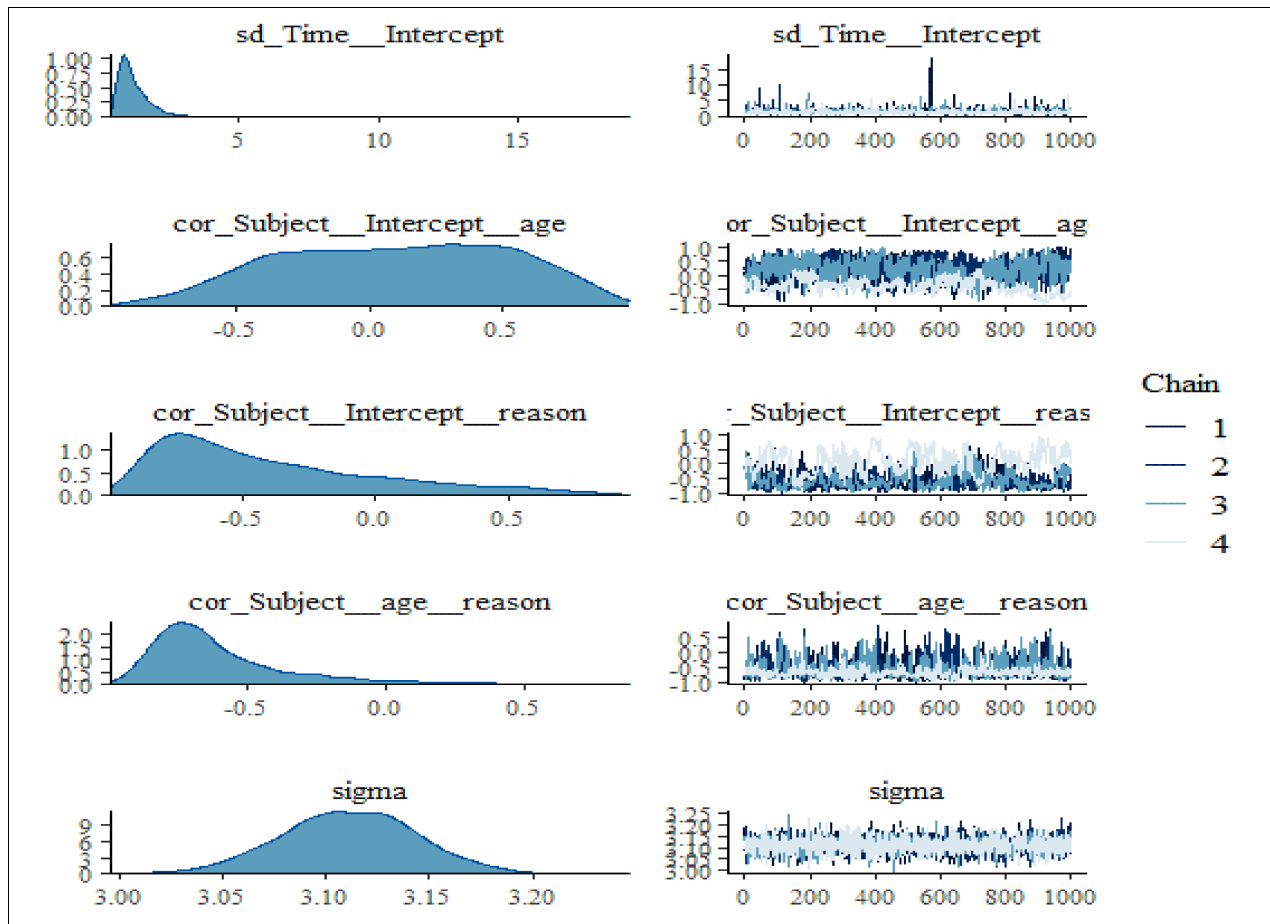
FIGURE 3 | Bayesian hierarchical varying slope convergence diagnosis